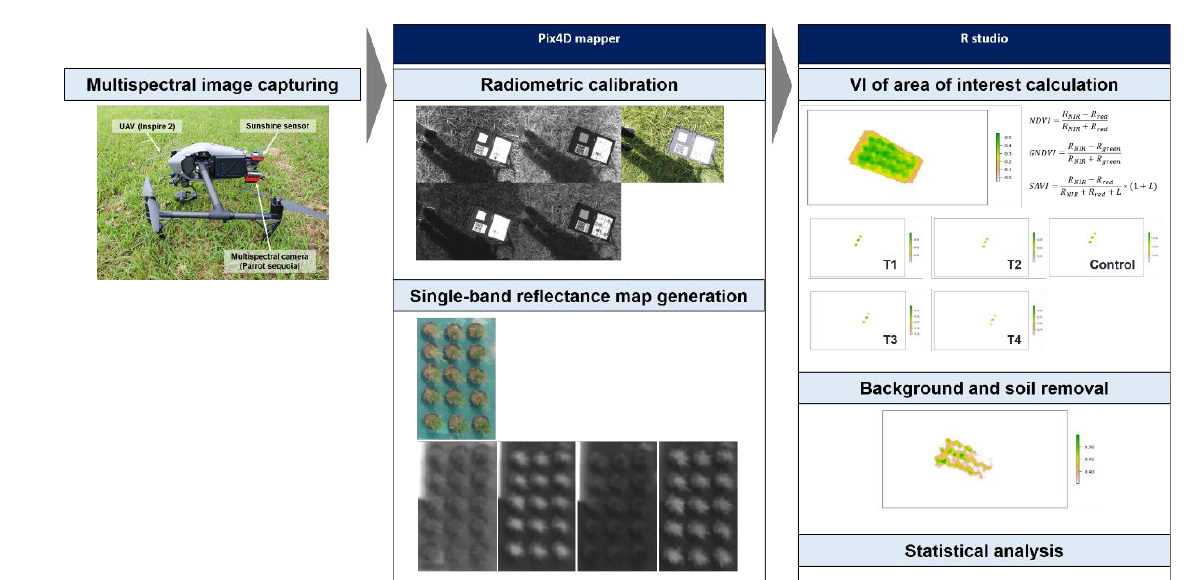
Figure 2. Imaging processing schematic for calculating VIs from UAV multispectral imagery. Pix4D mapper and R studio were used for image processing.